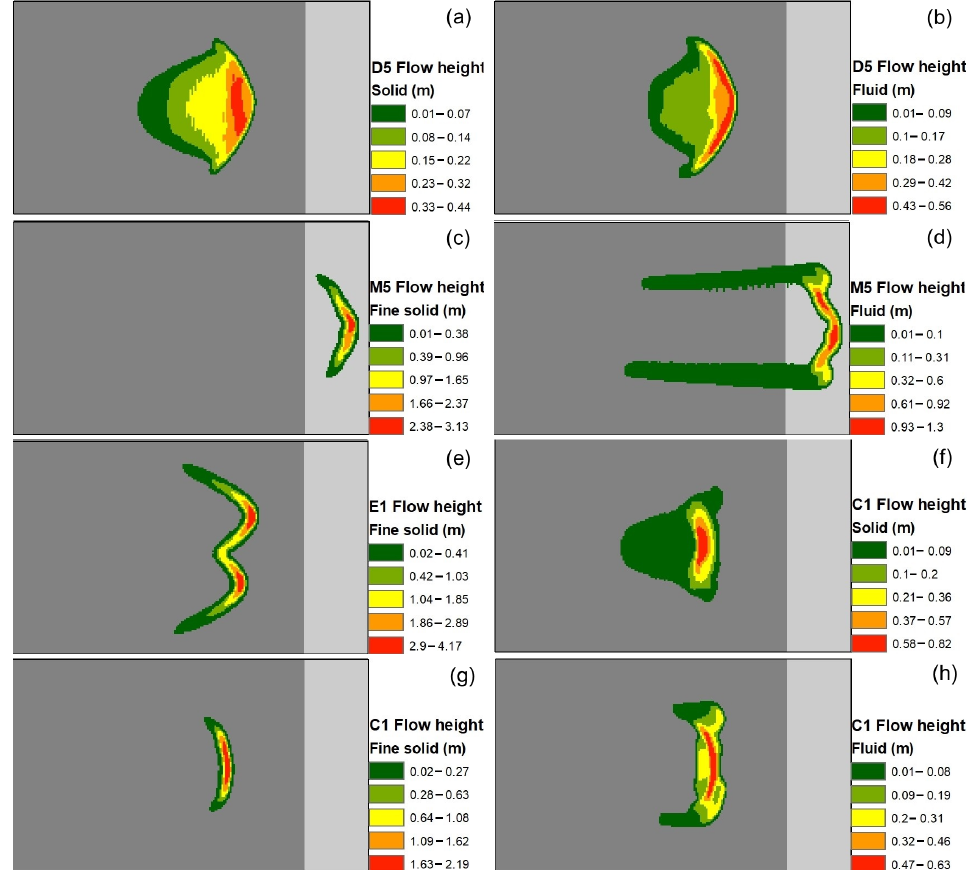
Figure 8. Top view for the height of flow for individual phases at 50 s for ( a ) D5: solid; ( b ) D5: fluid; ( c ) M5: fine solid; ( d ) M5: fluid; ( e ) E1: fine solid; ( f ) C1: solid; ( g ) C1: fine solid; ( h ) C1: